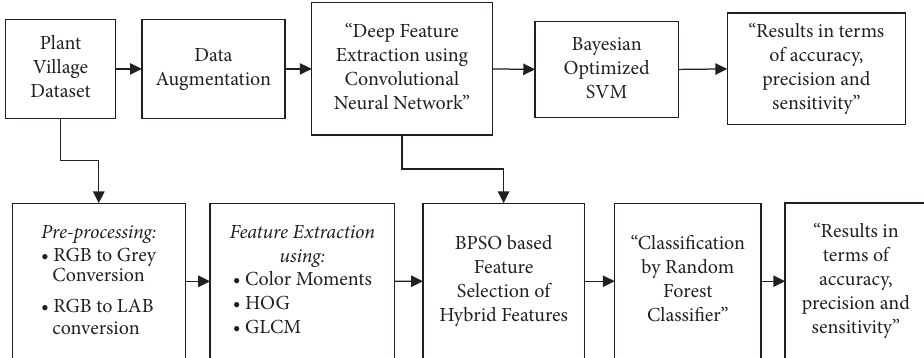
Figure 1: Block diagram for the hybrid approach of plant leaf disease